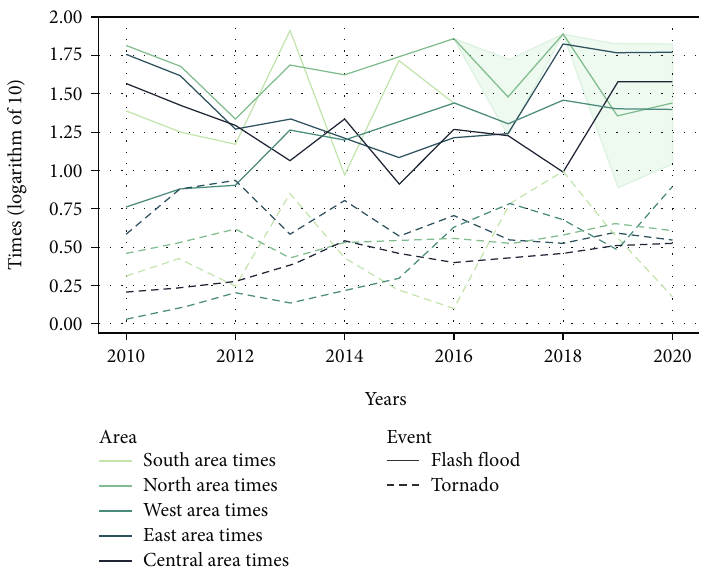
Figure 8: Frequency map of weather events in di ff erent regions over